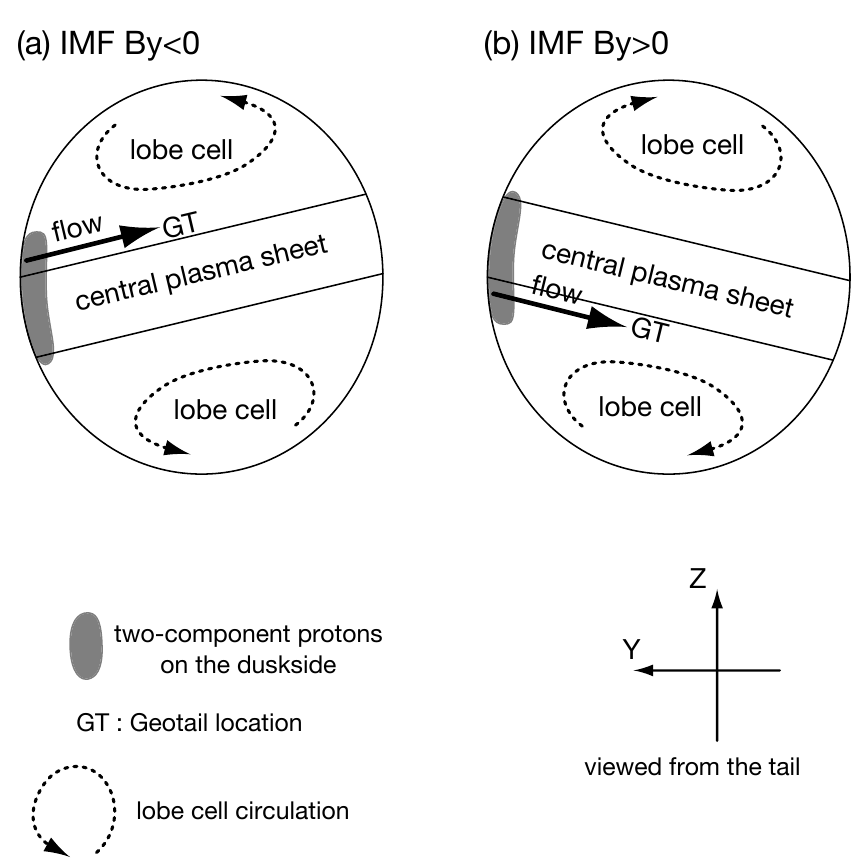
Fig. 13. A schematic view of the proposed scenario for generation of the dusk-to-midnight plasma flows in the high-latitude region of the plasma sheet. Cuts of the magnetotail for (a) neagtive and (b) positive IMF B Y cases are presented. The arrows with dotted curves show the lobe cell circulations whose sense depends on the IMF B Y . The abbreviation “GT” shows the plausible spacecraft locations, and the black arrows correspond to the expected dusk-to-midnight (dawnward) flows. Twisting of the plasma sheet that depends on the IMF B Y (Maezawa and Hori, 1998) is also represented in the